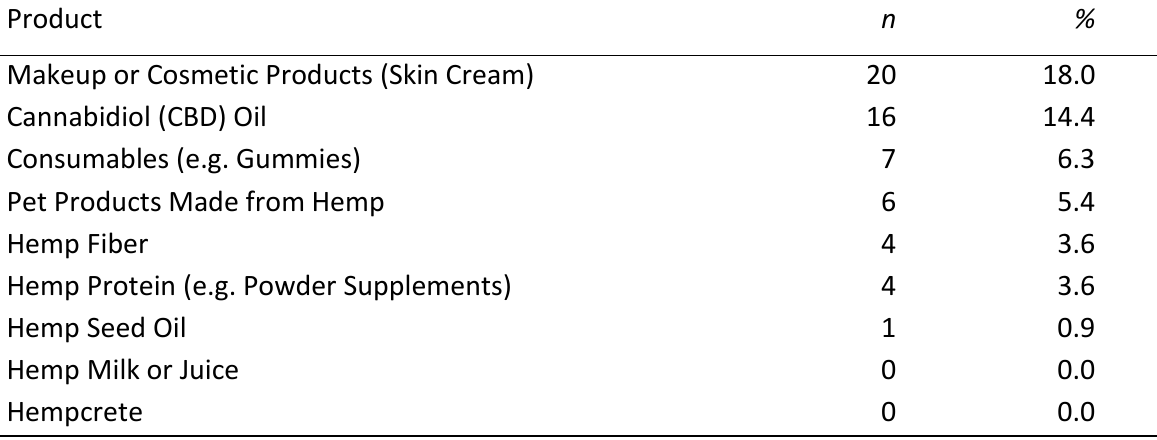
Hemp Products Purchased in The Past Six